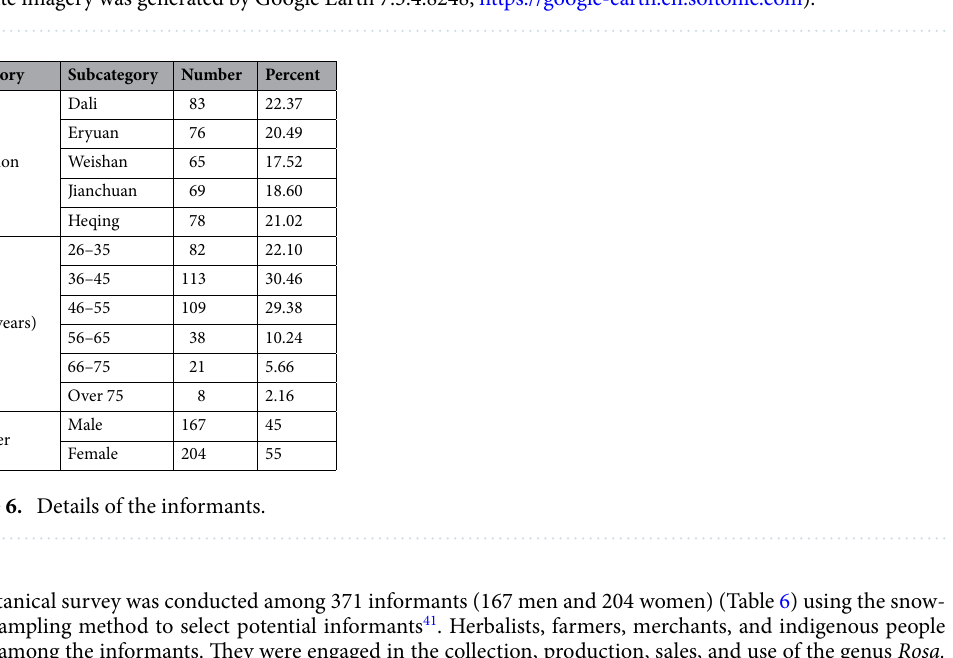
Figure 6. Location map of study sites. (Figure is created by ArcGIS 10.8, https:// devel opers. arcgis. com, the satellite imagery was generated by Google Earth 7.3.4.8248, https:// google- earth. en. softo nic. com).